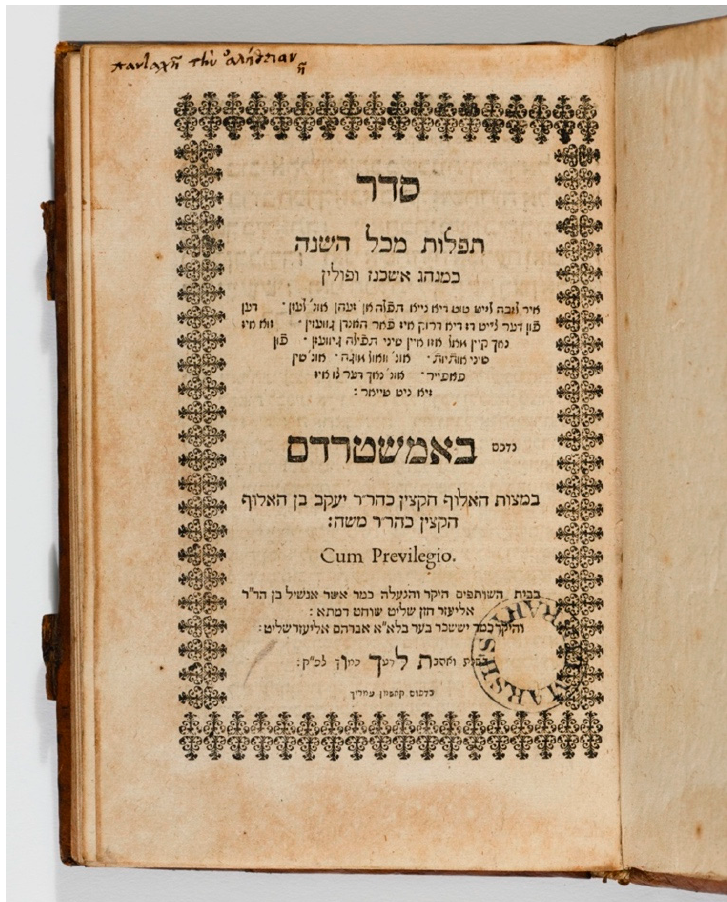
Figure 18. Seder Tefilot, Ashkenazi Prayer Book; Marsh’s Library C.3.4.2.